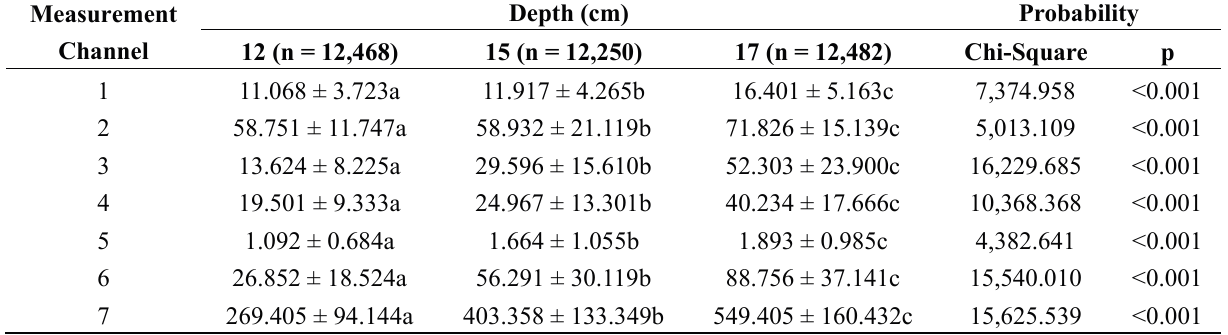
Table 7. Means and standard deviations of micro-strains ( με ) measured by gauges at different application depths. Mean differences tested with the Kruskal-Wallis test. Different letters indicate significant differences ( p < 0.05) obtained through the Mann-Whitney U-test for a specific measurement channel considering different depths.